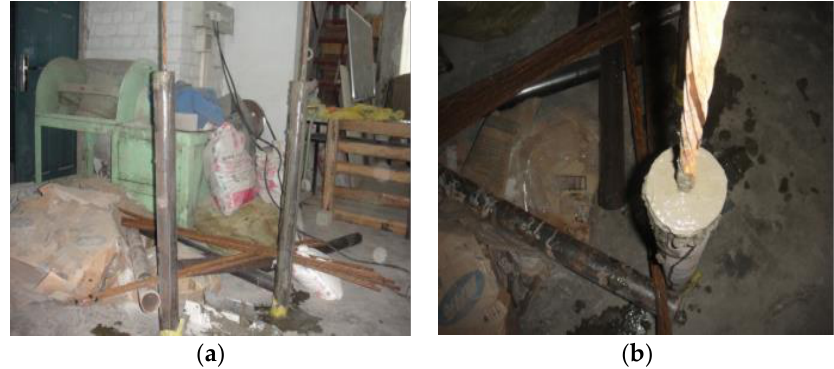
Figure 5. Bond stress test piece: ( a ) exterior; ( b ) interior.